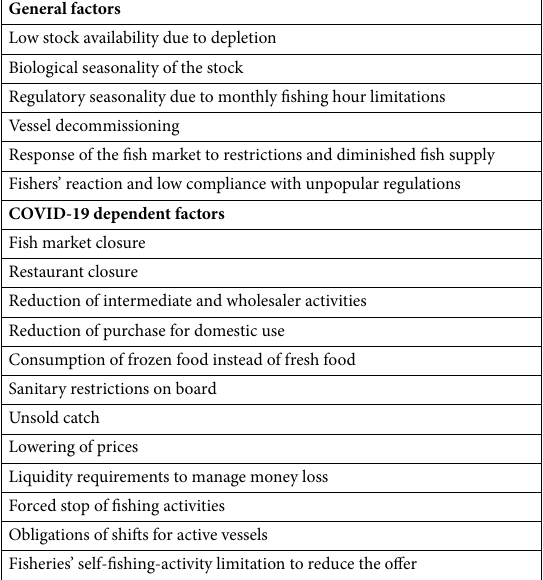
Table 1. List of general and COVID-19 dependent factors that negatively affect the fisheries in the Adriatic